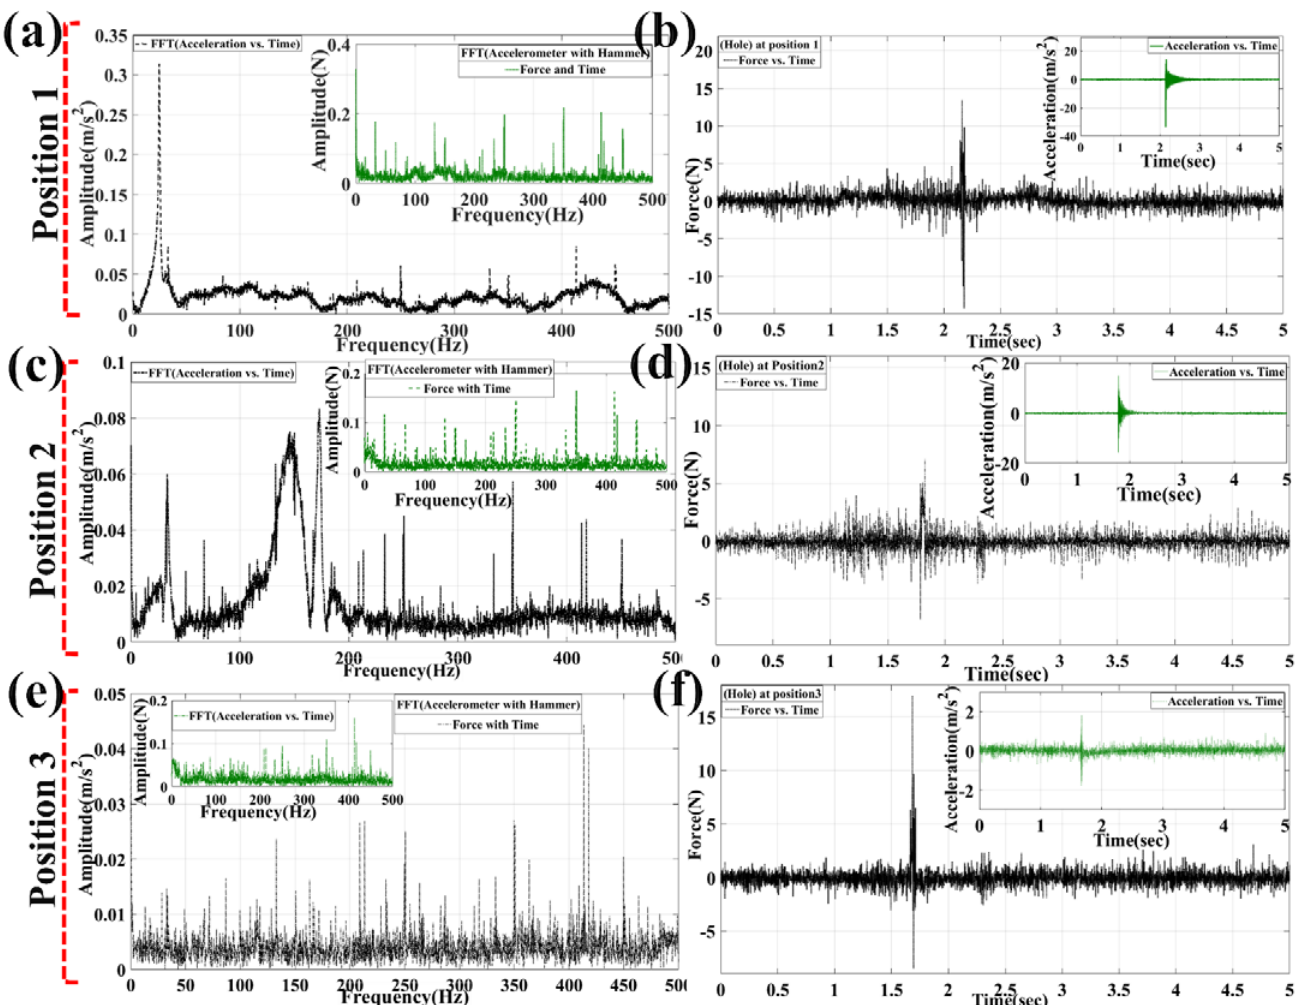
Figure 7. FFT graph plotted by MATLAB 2016 for obtaining modes of frequencies from acceleration and force amplitude with respect to time and its corresponding magnitude graphs at different positions of impact hammering (with (hole) defect): ( a , b ) FFT graphs and magnitude graphs for acceleration and force for position 1; ( c , d ) FFT graphs and magnitude graphs for acceleration and force for position 2; ( e , f ) FFT graphs and magnitude graphs for acceleration and force for position 3.